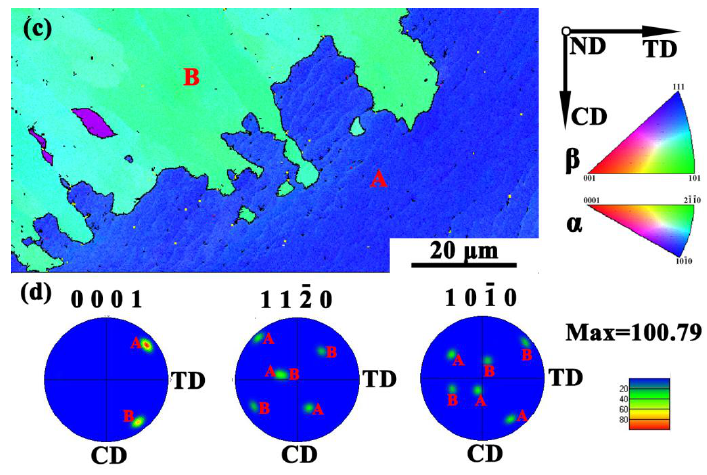
Figure 3. Initial microstructure of Ti-6Al-4V used in this study: ( a ) OM, ( b ) SEM, ( c ) the orientation map, and ( d ) pole figure.